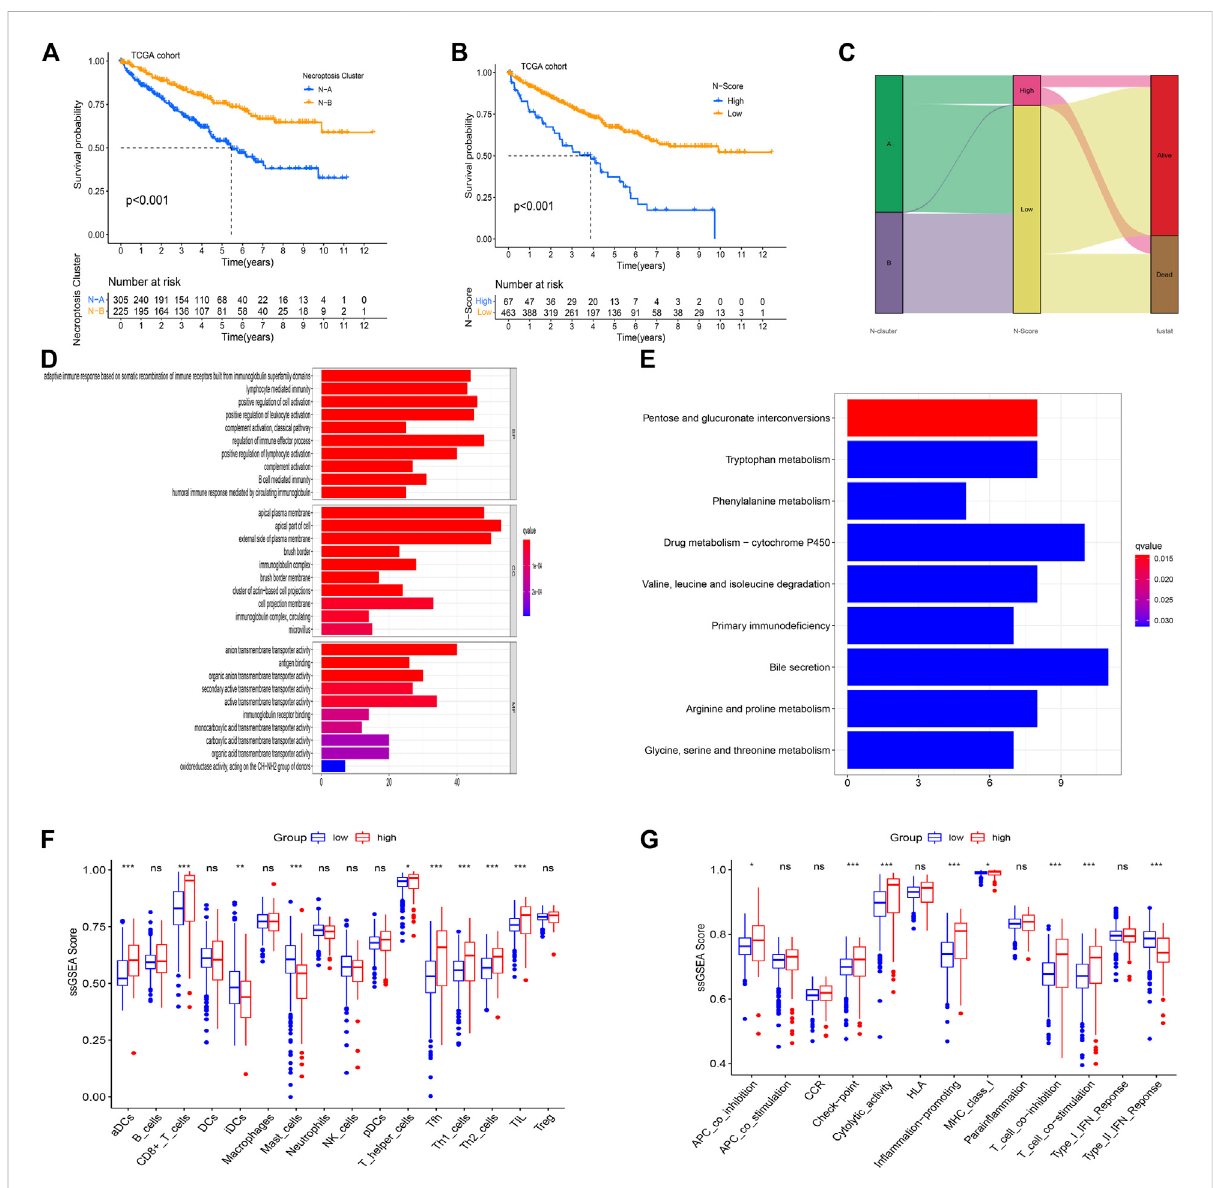
FIGURE 3 Enrichment analysis for the necroptosis-related score (N-Score). (A) Kaplan-Meier (K-M) survival curve shows that the effect of N-Clusters on overallsurvival(OS)intheTCGAcohort( p < 0.001). (B) Kaplan-Meier(K-M)survivalcurveshowsthattheeffectofN-Scoresonoverall survival(OS)in the TCGA cohort ( p < 0.001). (C) Sankey diagram shows the correlation between N-Cluster, N-Score and OS status. (D) GO analysis for differential expressedgenes(DEGs)between low N-Score group and highN-Score group. (E) Kyoto Encyclopediaof Genesand Genomes(KEGG) analysis for DEGs between N-Score groups. (F,G) The difference for ssGSEA scores of 16 immune cells (F) and 13 immune related functions (G) between N-Score groups (*: p < 0.05, **: p < 0.01, and ***: p <